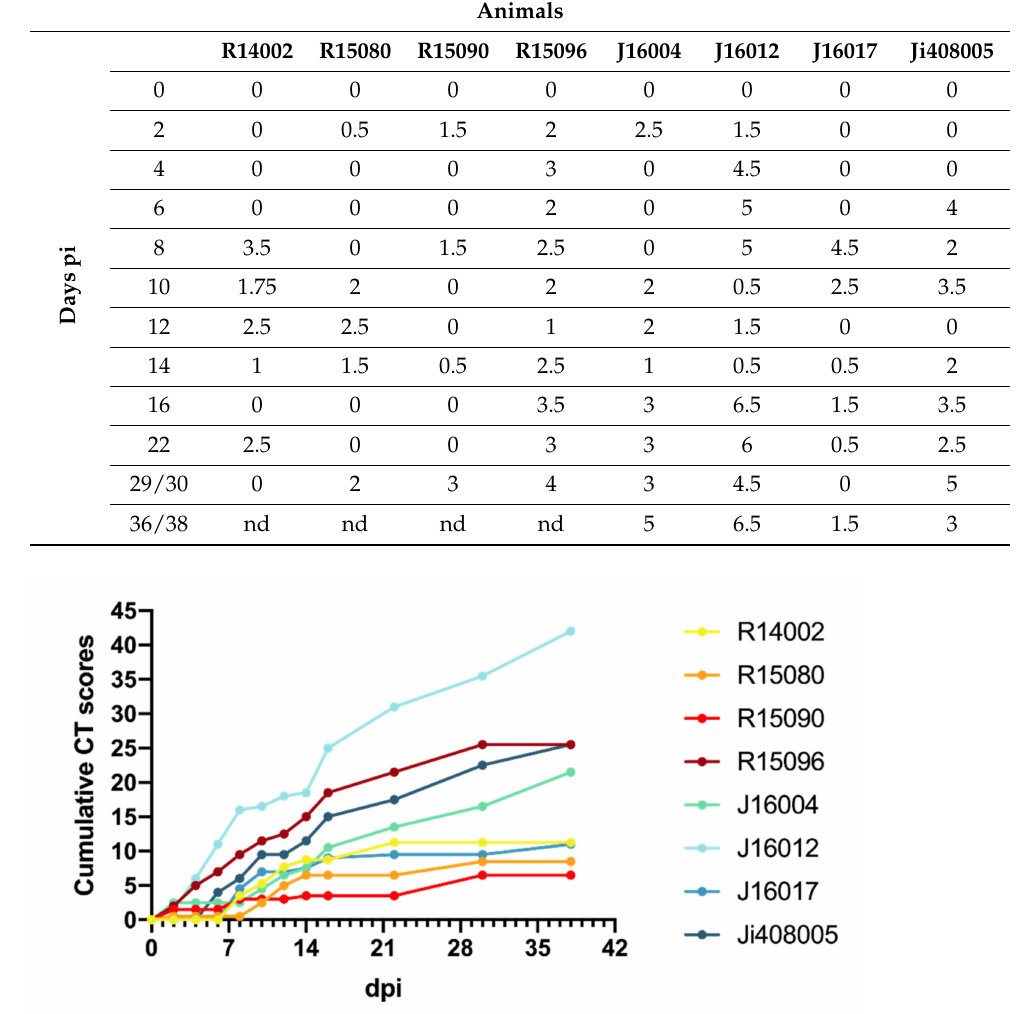
Figure 5. Cumulative CT scores. Cumulative CT scores for each animal were calculated based on the CT scores depicted in Table